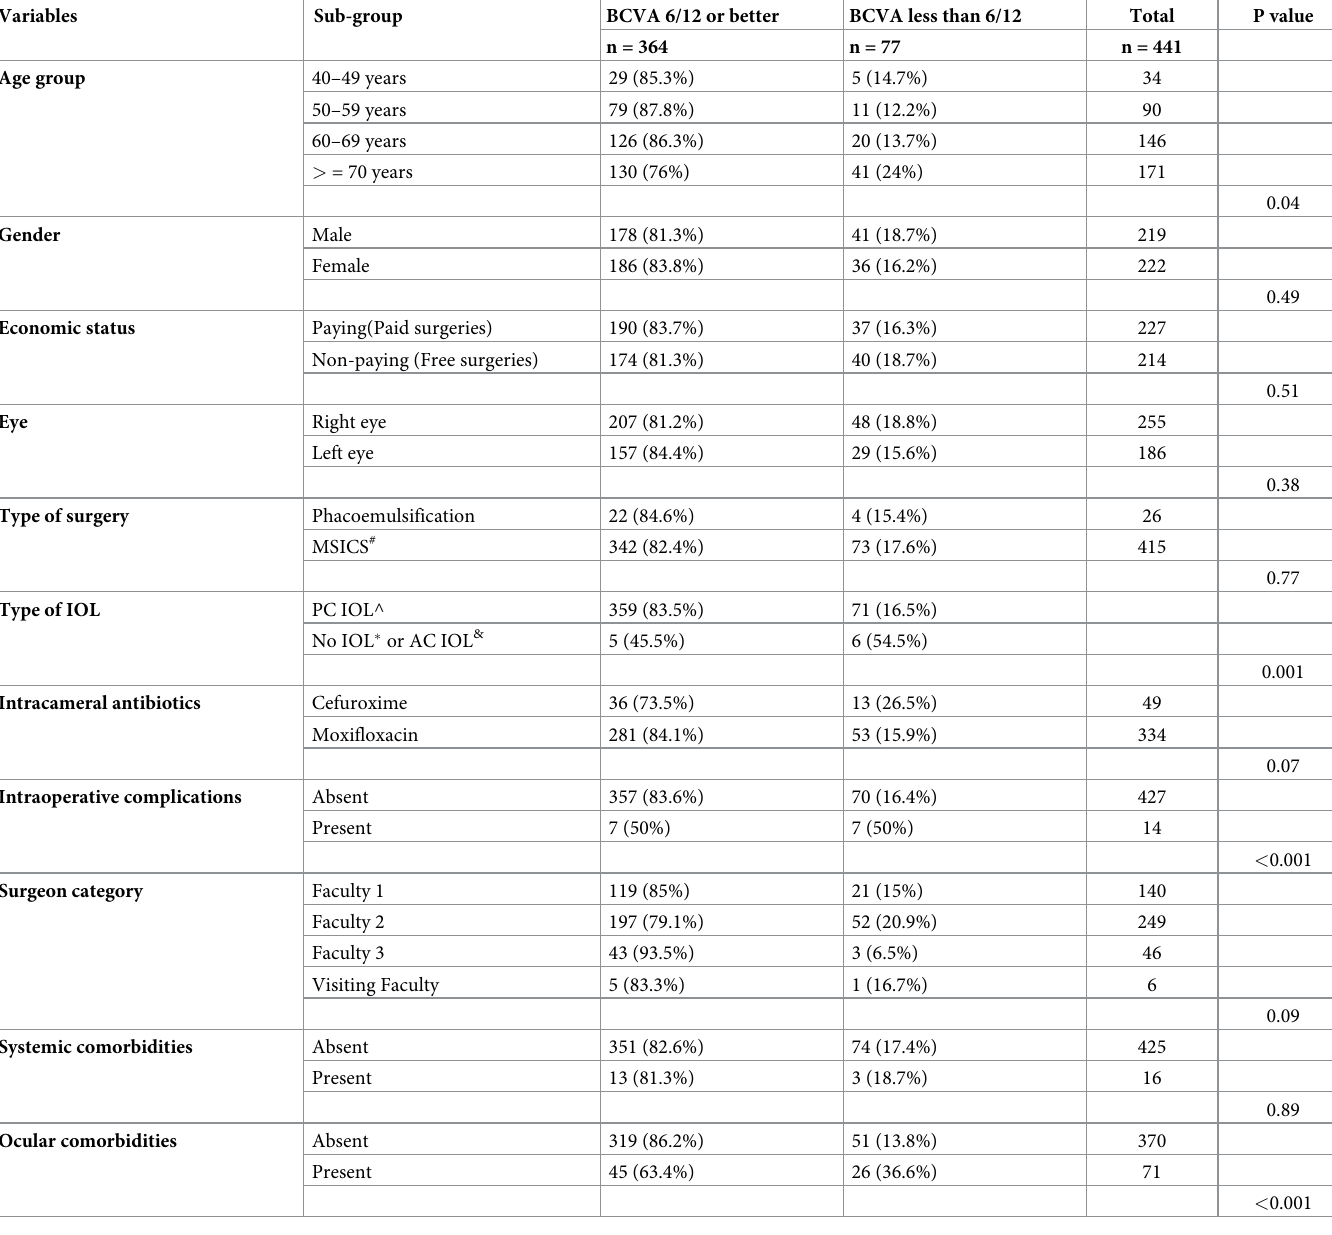
Table 4. Difference between demographics and ocular characteristic of good versus poor